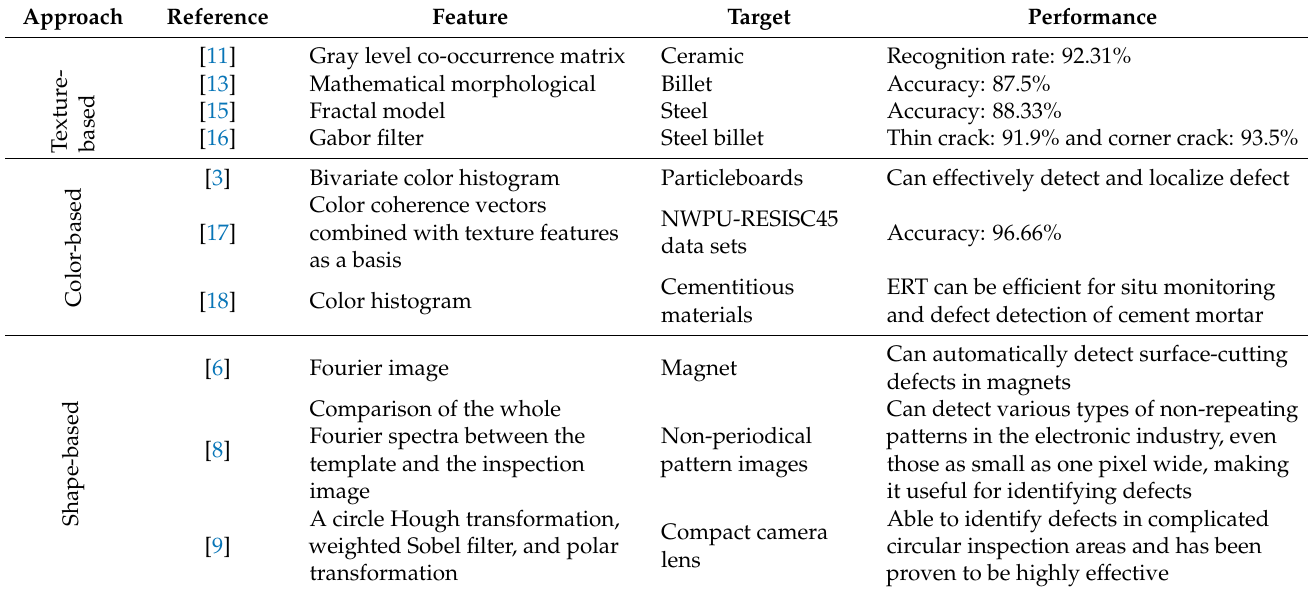
Table 1. Recent applications using machine-learning-based vision algorithms for detecting sur- face defects in industrial products, categorized into three categories based on texture, color, and shape features.